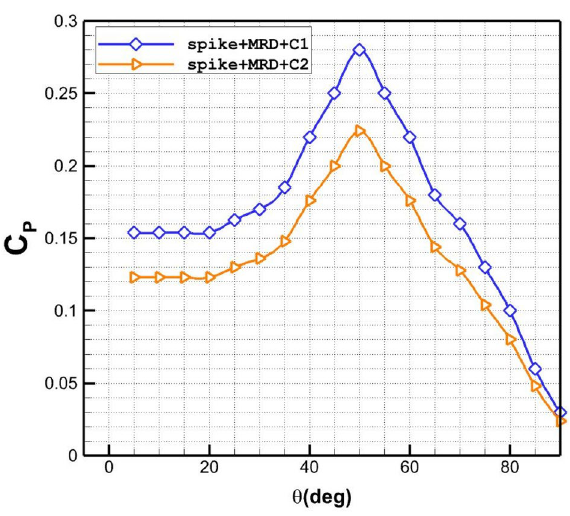
Figure 11. Influence of the different disk coolant injection systems on Pressure coefficient